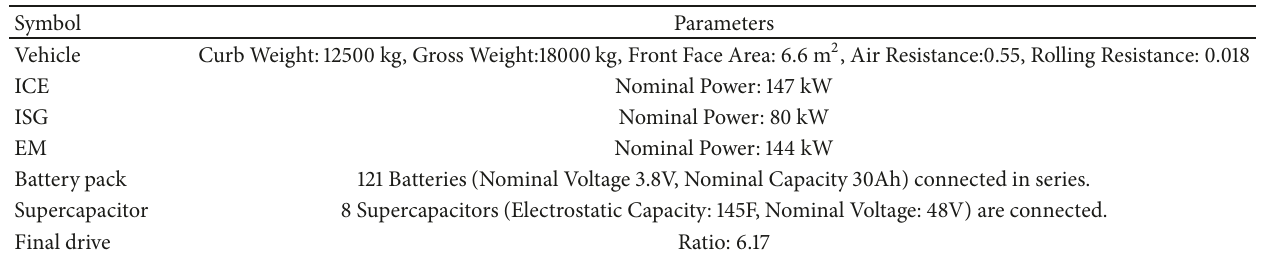
Table 7: Basic parameters of whole